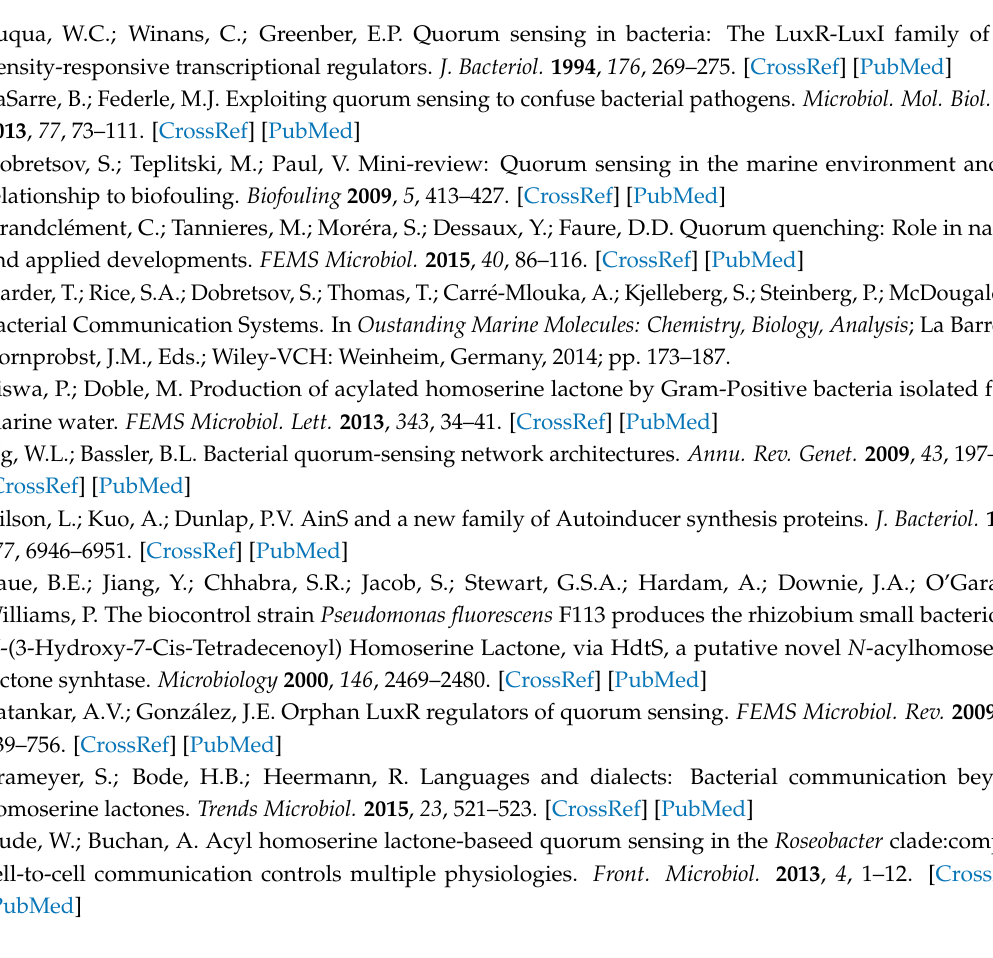
Supplementary Materials: The following are available online at http://www.mdpi.com/2073-4425/9/2/100/s1, Table S1: Total isolated strains from different samples and culture media, showing the number and percentage of strains with putative QS and QQ activity against C6- and C12-HSL obtained using the solid plate C. violaceum assay. Media used: tryptone soy agar 1% NaCl (TSA-1), marine agar (MA), diluted marine agar (MA 1/100), and filtered autoclaved seawater medium (FAS) supplemented with 0.5 g/L polymers: agarose, chitin, and starch